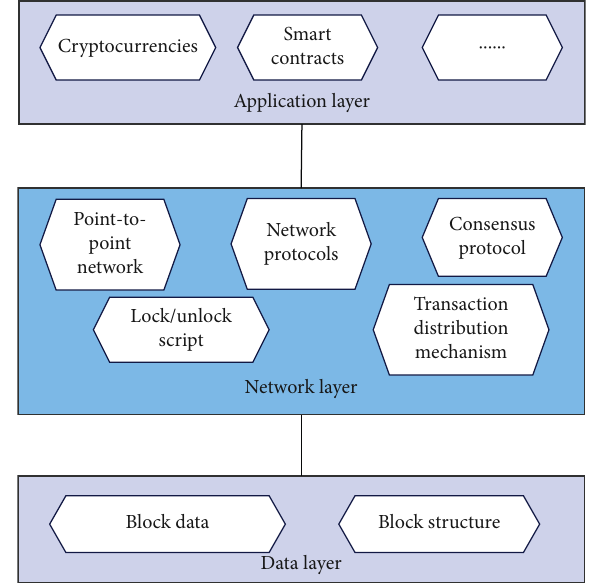
Figure 5: Blockchain